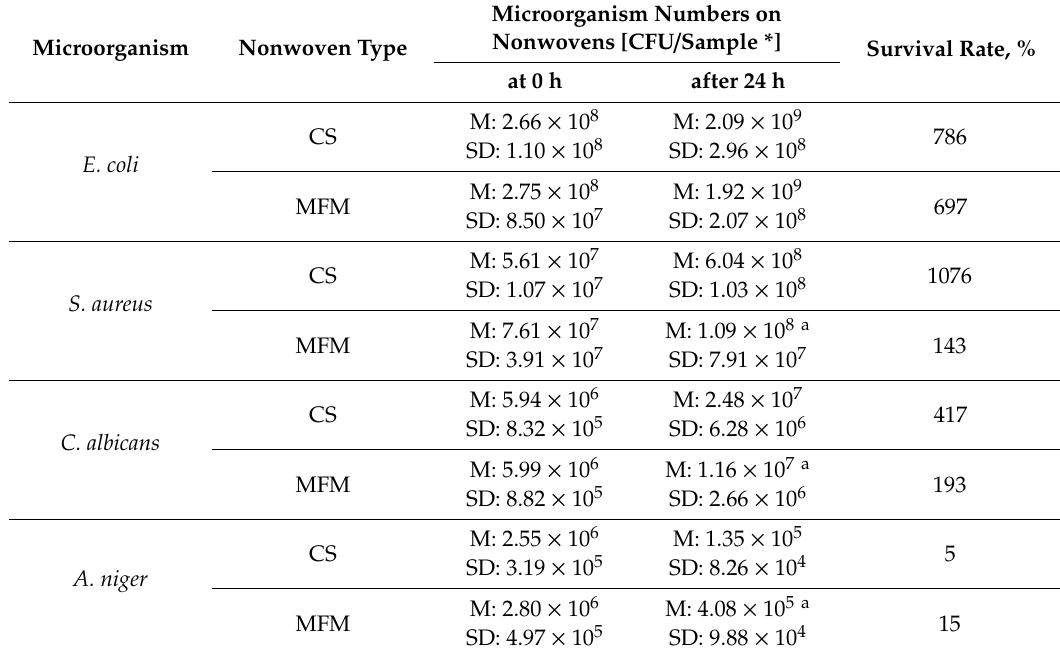
Table 1. Bacteria number, survival rate, and antimicrobial activity of nonwovens.